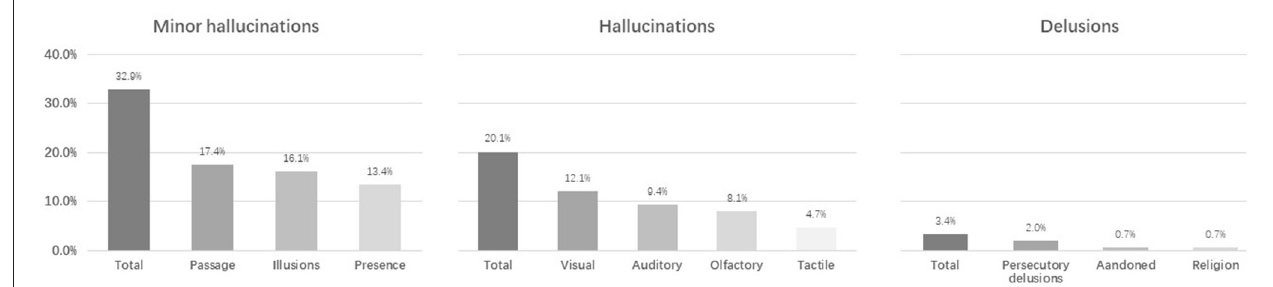
FIGURE 1 | The frequency of various types of psychotic symptoms in the Parkinson’s disease